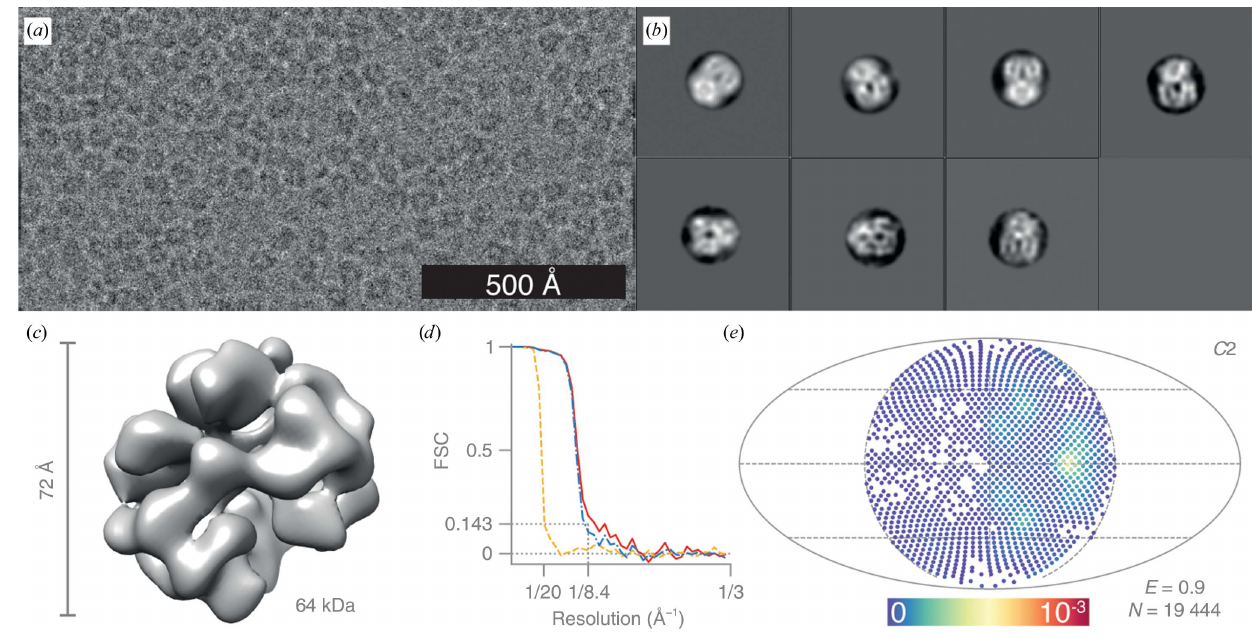
Figure 6 Structure of haemoglobin determined at 100 keV. ( a ) Typical micrograph after motion correction. Contrast is adjusted to (cid:8) 3 (cid:3) from the mean intensity. ( b ) 2D class averages. ( c ) Sharpened masked 3D reconstruction of haemoglobin from N = 19 444 particles with C 2 symmetry. ( d ) Gold-standard FSC plot corresponding to the calculated map, showing the correlation between the phase-randomized (yellow), unmasked (blue) and masked (red) half-maps. The plot terminates at the Nyquist frequency. ( e ) Orientation distribution of the haemoglobin particles contributing to the final reconstruction (Mollweide projection). All Euler angles are assigned within one asymmetric subunit for the C 2 symmetric particle. The colour scale (linear) corresponds to the normalized density of views (blue, low; red, high). E = 0.9 is the efficiency of the orientation distribution, indicating nearly uniform sampling of the particle